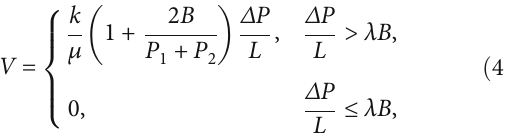
Figure 2: Steady methane fl ow fi eld area around a discoid cave where H is the cave radius and L methane movement in the linear seepage zone and nonlinear seepage zone,